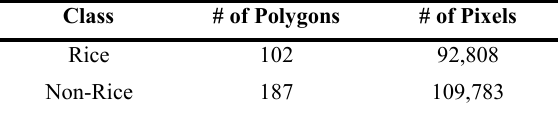
Table1. Characteristics of training data used for the